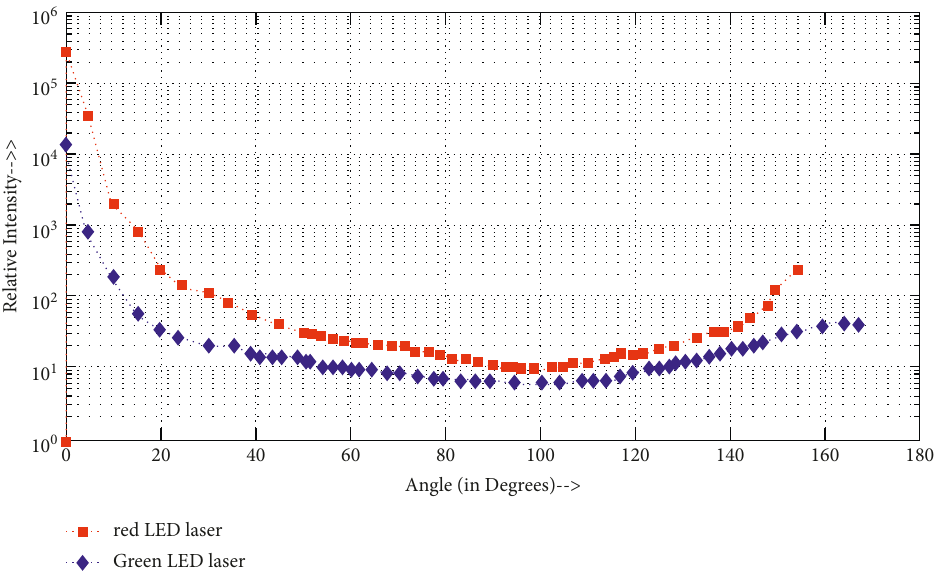
Figure 10: Cellular scattering curves obtained under 12 different 1000-nm light angles, with the black line being the mean [6].